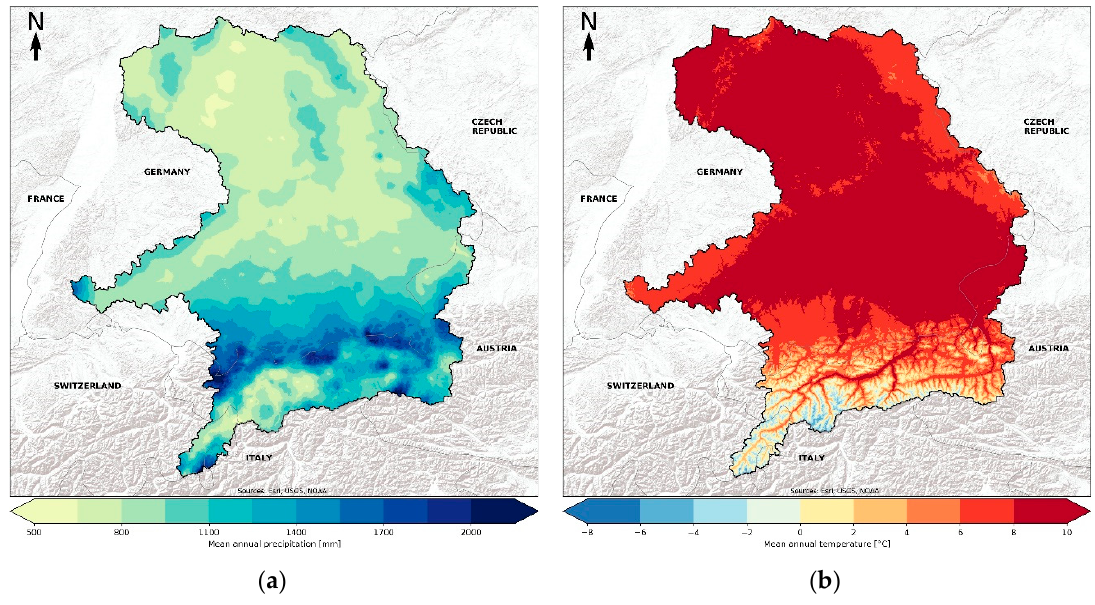
Figure 2. Mean annual precipitation [mm] ( a ) and air temperature [°C] ( b ) of the Hydrological Bavaria for the reference period 1981–2010 derived from the meteorological reference dataset (see Section 2.2.2).